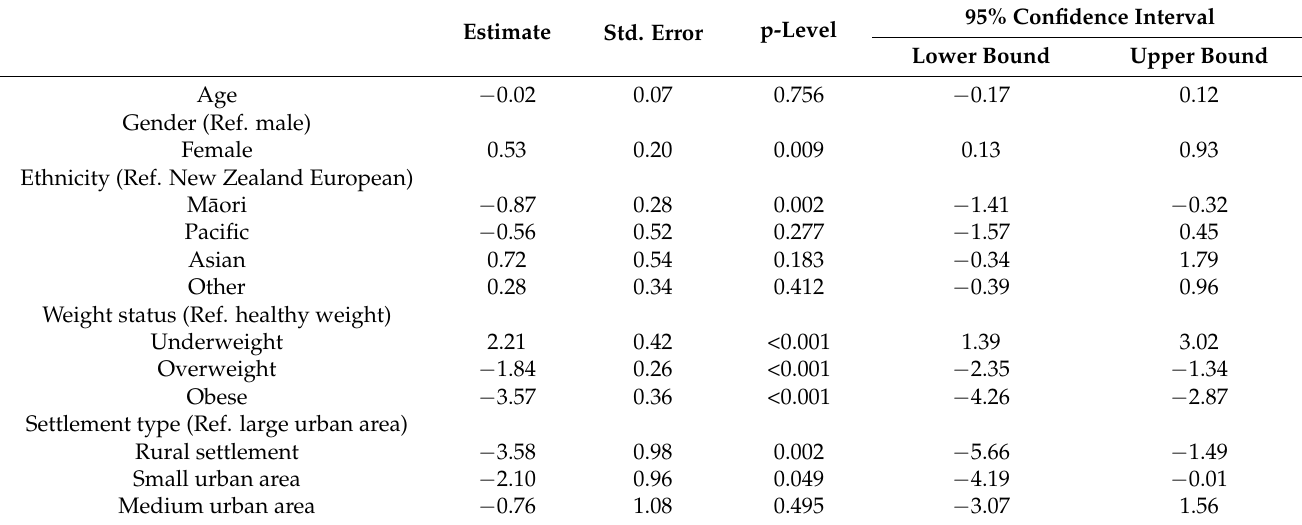
Table 3. Multivariate correlates of relative school bag weight in adolescents. Estimate